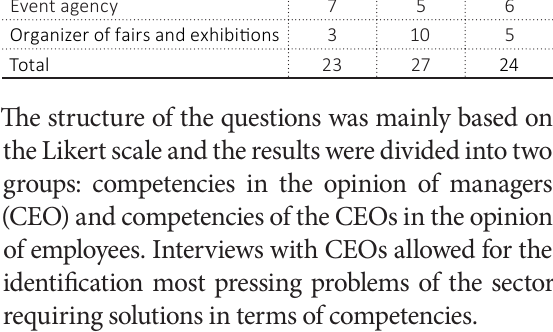
Table 4. Social competencies of the enterprise team